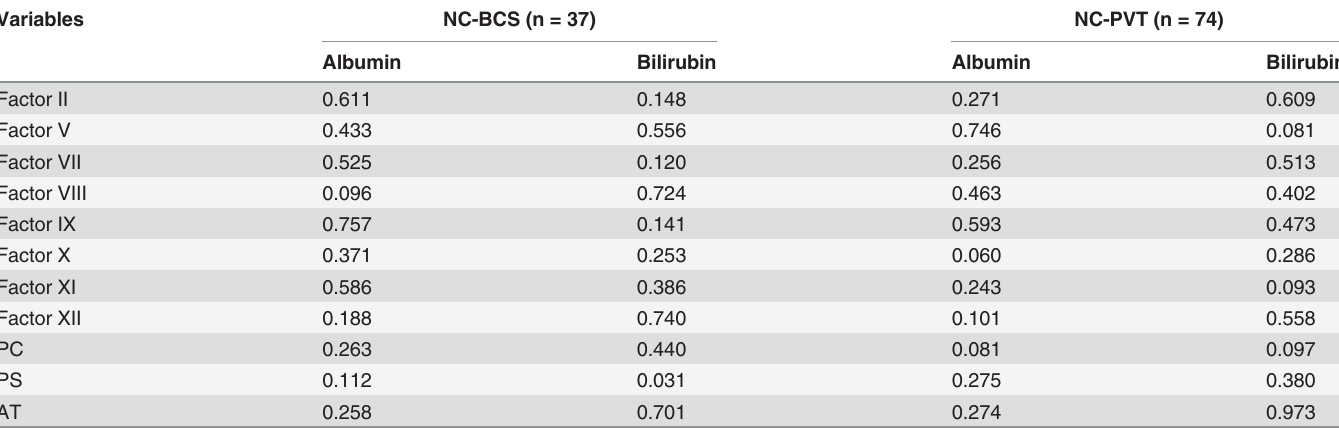
Table 4. The P values of correlation between pro- and anti-coagulation factors with liver function parameters (albumin and bilirubin) for patients with NC-BCS and NC-PVT. Variables